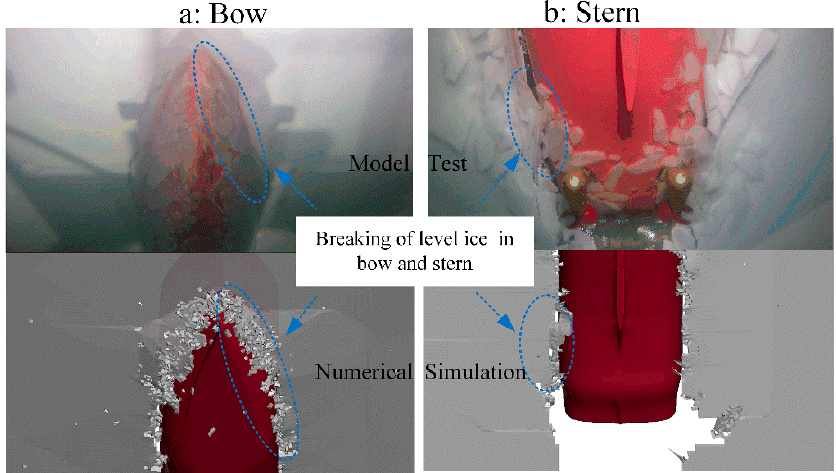
Figure 8. Two underwater views of the ice–hull interaction. ( a ) Bow; ( b ) stern. Table 4. Numerical ice resistance and model test ice resistance, and the deviation of speed of each ( λ = 18.667).